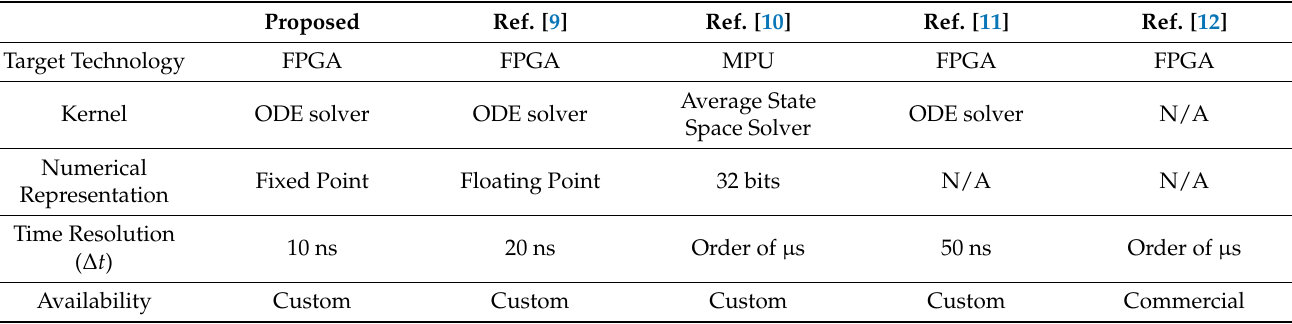
Table 6. Hardware emulator